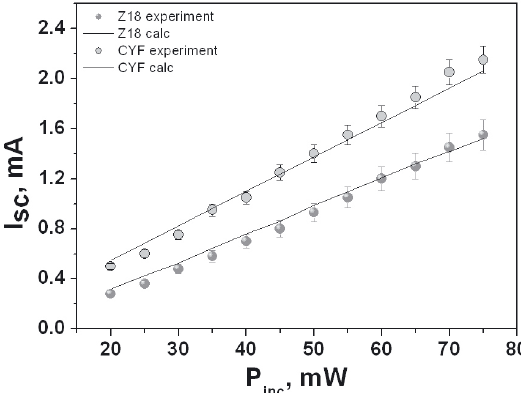
Fig. 6. Photocurrent as a function of the 1.54 μ m excitation power of the upconverter: experimental results and calculated values using the simple model.